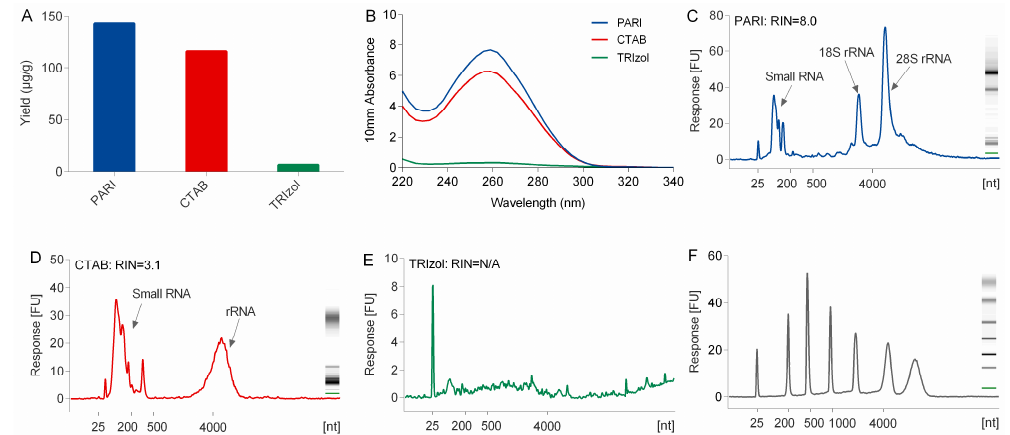
Figure 2. Comparison of the yield ( A ), purity ( B ), and integrity (RIN values reported by bioanalyzer in C , D and E ) of ginseng RNA isolated using the PARI mehthod, TRIzol reagent, and CTAB method. ( F ) RNA ladder (25–6000 mer).